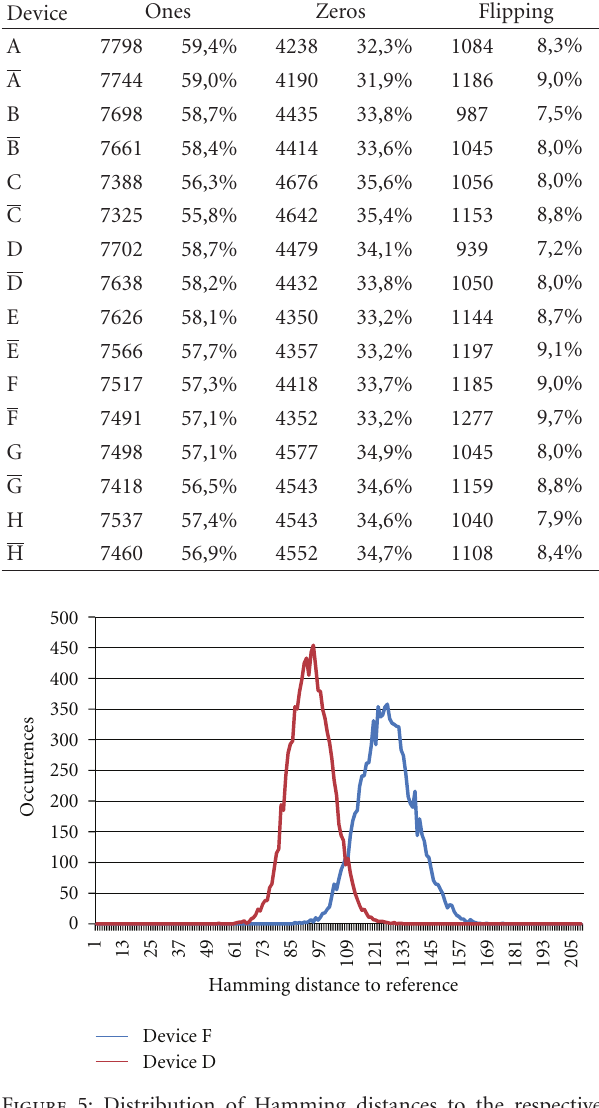
Figure 5: Distribution of Hamming distances to the respective reference streams for unconfigured devices D and F and 10,000 measurements